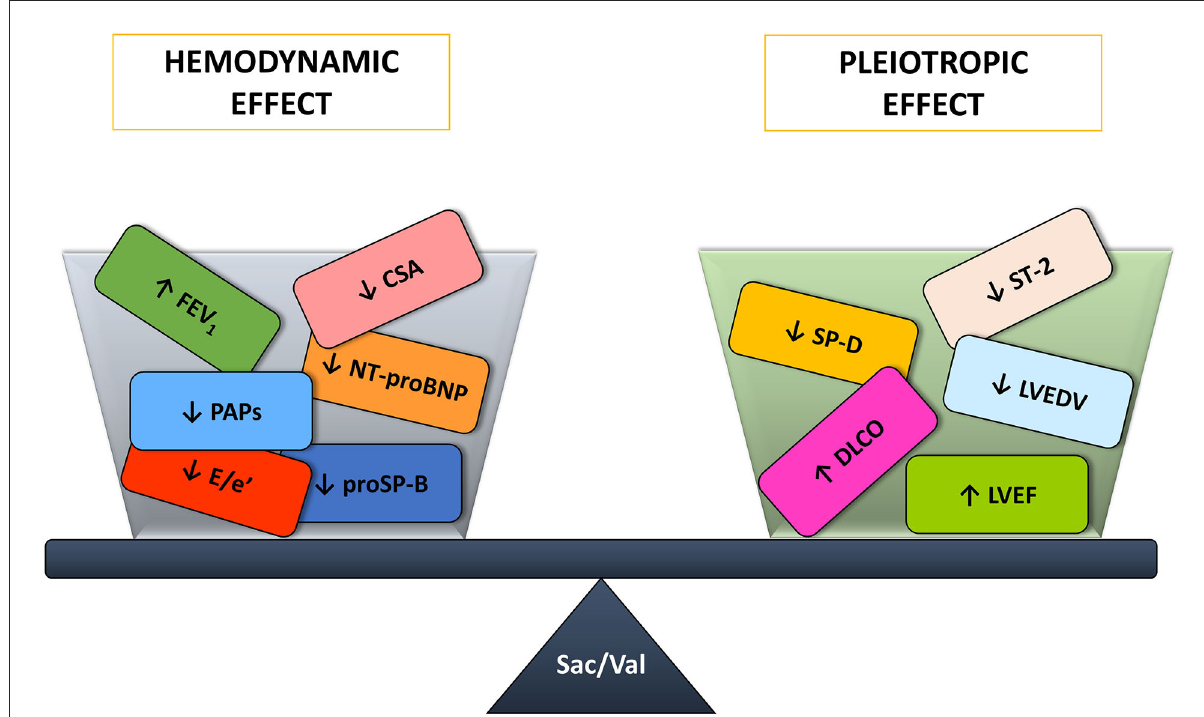
FIGURE3 Sacubitril/Valsartan benefits on the cardiorespiratory system arise from the balance between the hemodynamic and pleiotropic effects. CSA, central sleep apneas; DLCO, diffusing capacity of the lungs for carbon monoxide; E/e’, ratio of the transmitral early peak velocity by pulsed wave Doppler and the early diastolic mitral annulus velocity by tissue Doppler; FEV 1 , forced expiratory volume in 1s; LVEDV, left ventricle end diastolic volume; LVEF, left ventricle ejection fraction; NT-proBNP, amino terminal pro-B-type natriuretic peptide; PAPs, systolic pulmonary artery pressure; proSP-B, immature form of surfactant protein isoform B; Sac/Val, Sacubitril/Valsartan; SP-D, surfactant protein isoform D; ST-2, interleukin